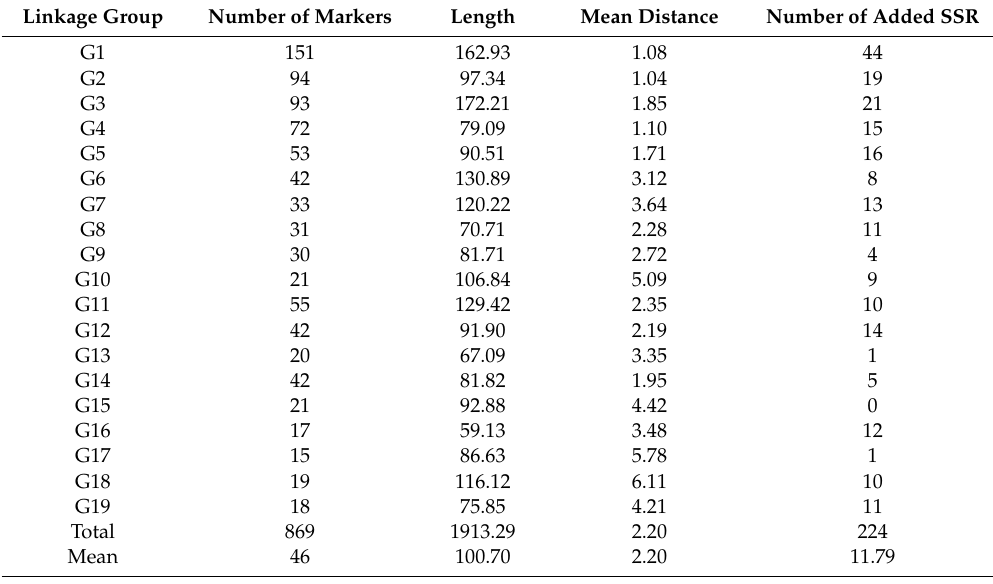
Table 1. Distributions of markers on 19 linkage groups of Eucommia ulmoides.